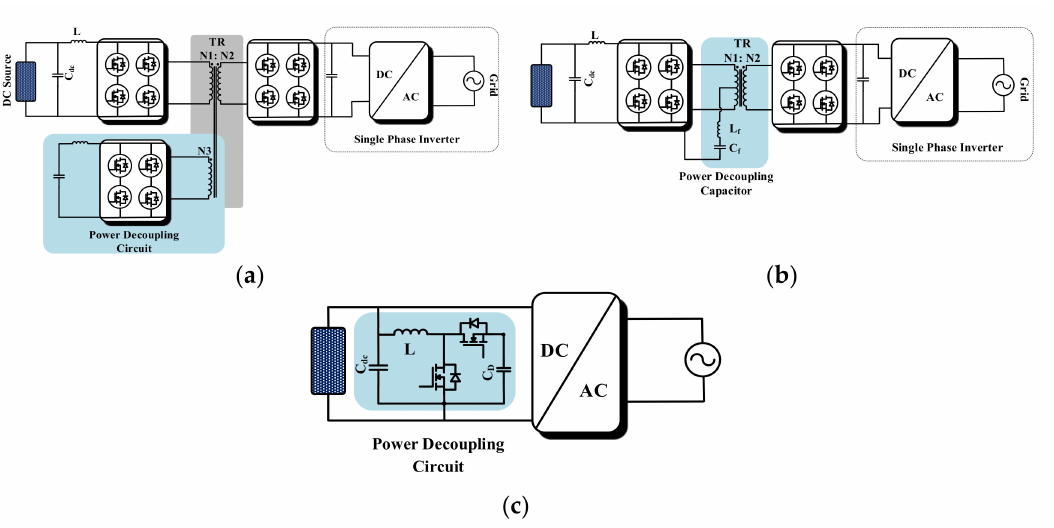
Figure 1. Conventional power decoupling methods: ( a ) methods in [14–16]; ( b ) method in [12]; ( c ) method in [8].